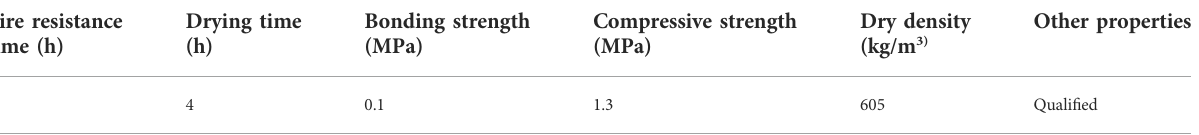
TABLE 6 Index of fi re-retardant coating.